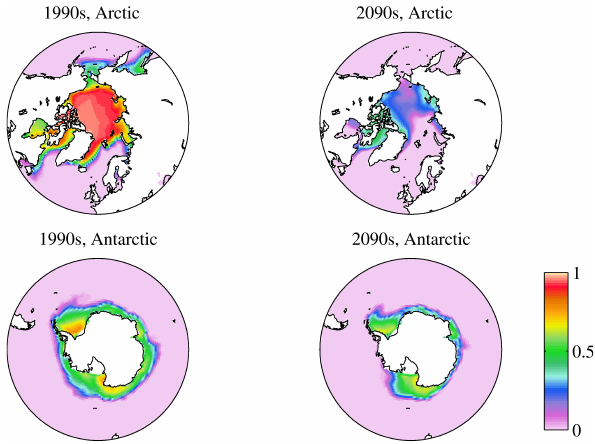
Fig. 11. Seasonal maximum 1990s (left) and 2090s (right) sea-ice Fig. 9. Seasonal maximum 1990s ( left ) and 2090s ( right ) sea–ice cover for the Arctic ( top ; March) and Antarctic cover for the Arctic (top; March) and Antarctic (bottom; Septem- ( bottom ;September). Sea–icecoverisnon–dimensional. ber). Sea-ice cover is non-dimensional.